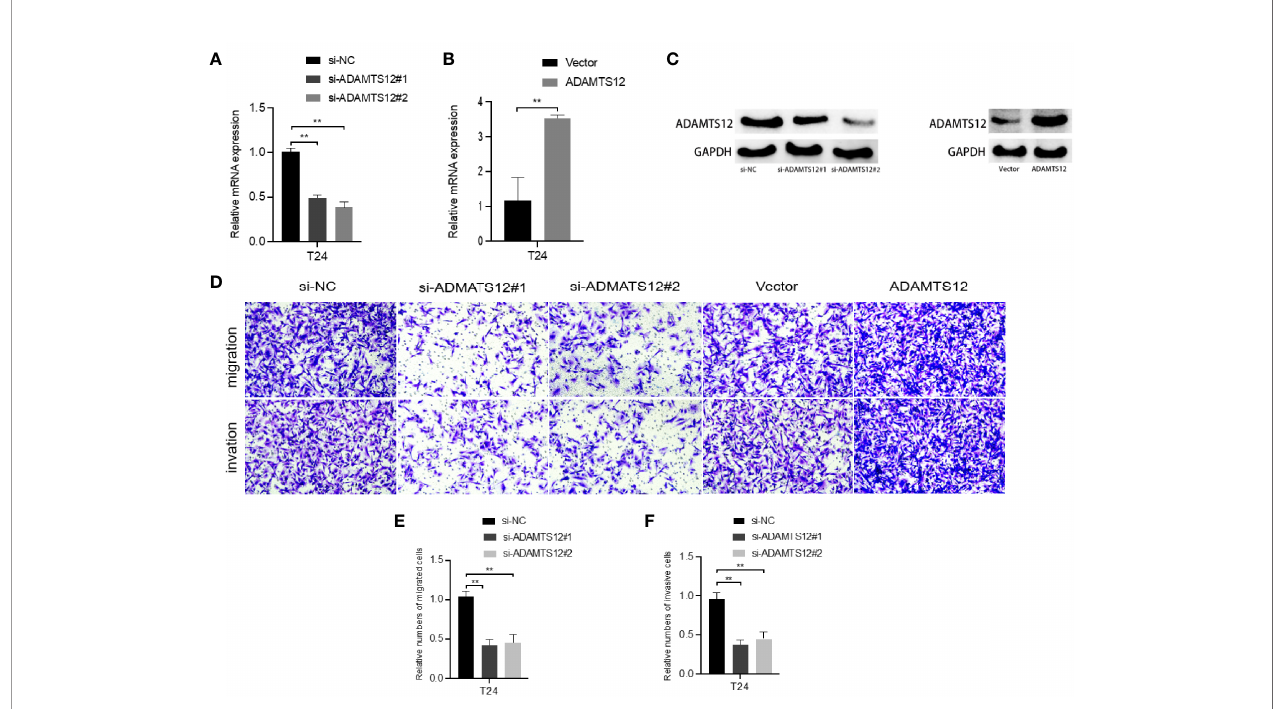
FIGURE 8 | Effect of knockdown or overexpression of ADAMTS12 on T24 cells. (A) Validation of the knockdown effect of ADAMTS12 at the mRNA level in T24 cells. (B) Validation of the effect of ADAMTS12 overexpression at the mRNA level in T24 cells. (C) Validation of knockdown versus overexpression of ADAMTS12 protein levels. Transwell assays (D) show that knockdown of ADAMTS12 attenuates cell invasion. (E) Relative numbers of migrated cells. (F) Relative numbers of invasive cells. **P < 0.01.